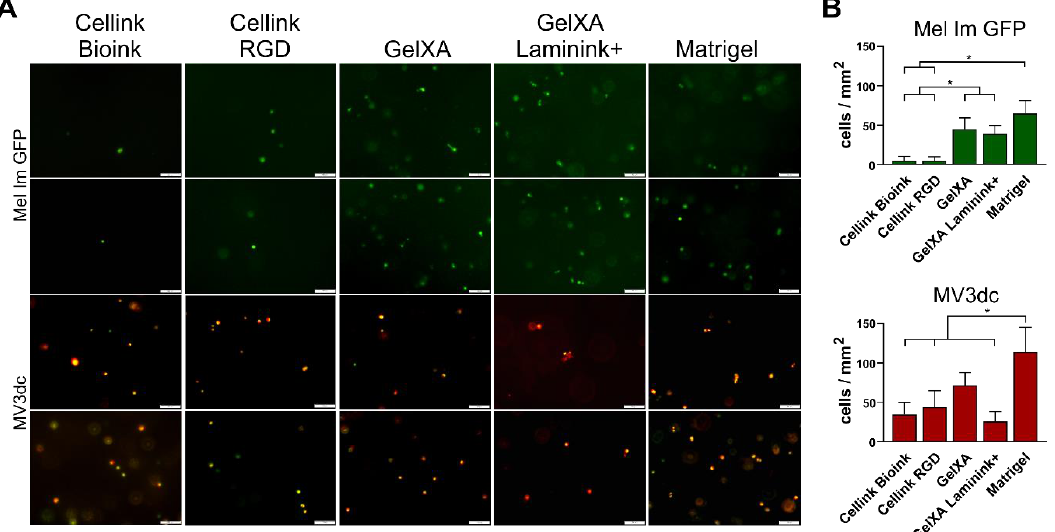
Figure 2. Survival of melanoma cells in the bioinks. ( A ) Two representative fluorescence microscope images of each of the cell lines Mel Im GFP and MV3dc one day after 3D printing. Both melanoma cell lines survived the bioprinting and crosslinking process in all bioinks. Scale bars represent 100 µm. ( B ) Quantification of living cells per mm 2 in the bioinks on the day Mel Im GFP showed low amounts of living cells in both Cellink -based inks, a higher rate in GelXA -based inks, and revealed the significantly highest amount of viable cells in Matrigel. MV3dc revealed appropriate amounts of living cells in all materials, with the lowest amount in the Cellinks and GelXA Laminink + , and the significantly highest amount in Matrigel. * p ≤ 0.05 (One-way